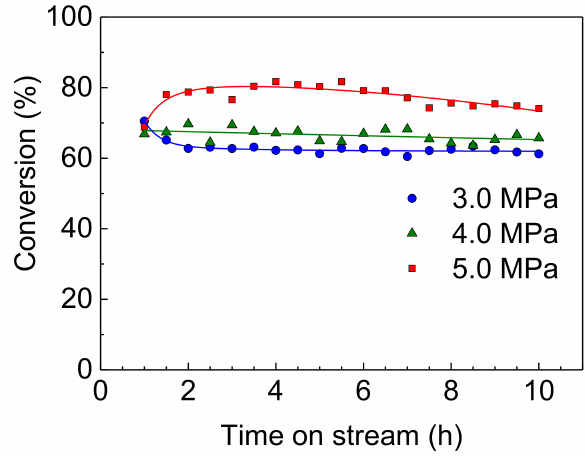
Figure 6. HDS of 4,6-DMDBT over a NiMoS catalyst at 310 ◦ C and 3.0–5.0 MPa.